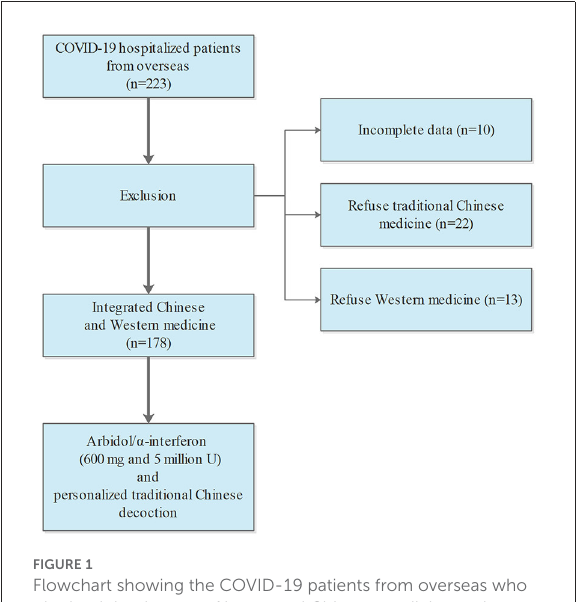
FIGURE1 Flowchart showing the COVID-19 patients from overseas who obtained the therapy of integrated Chinese medicine and Western